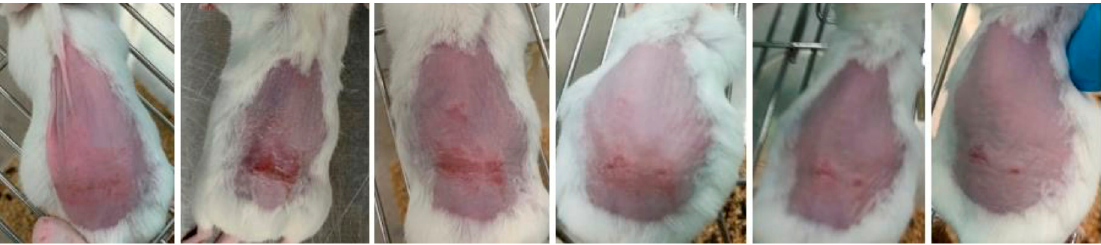
Figure 7. Progress of skin healing in test group treated with AgNPs incorporated in Pluronic ® F127 hydrogel (66 nM, from day 3 to day 8, following the course of treatment).